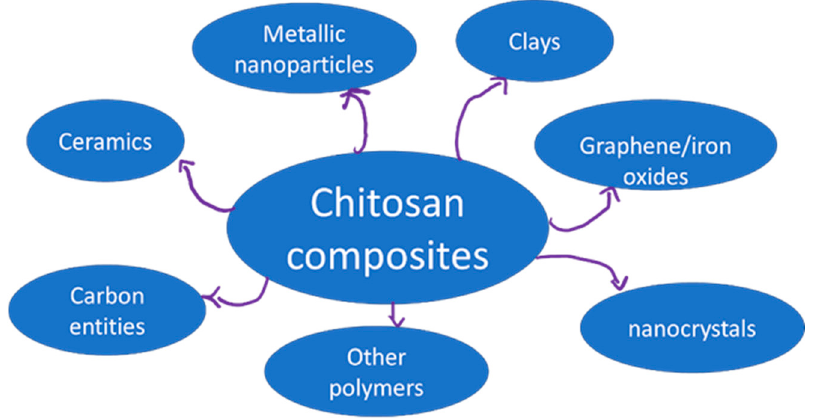
Figure 1. Types of components found on chitosan composites.